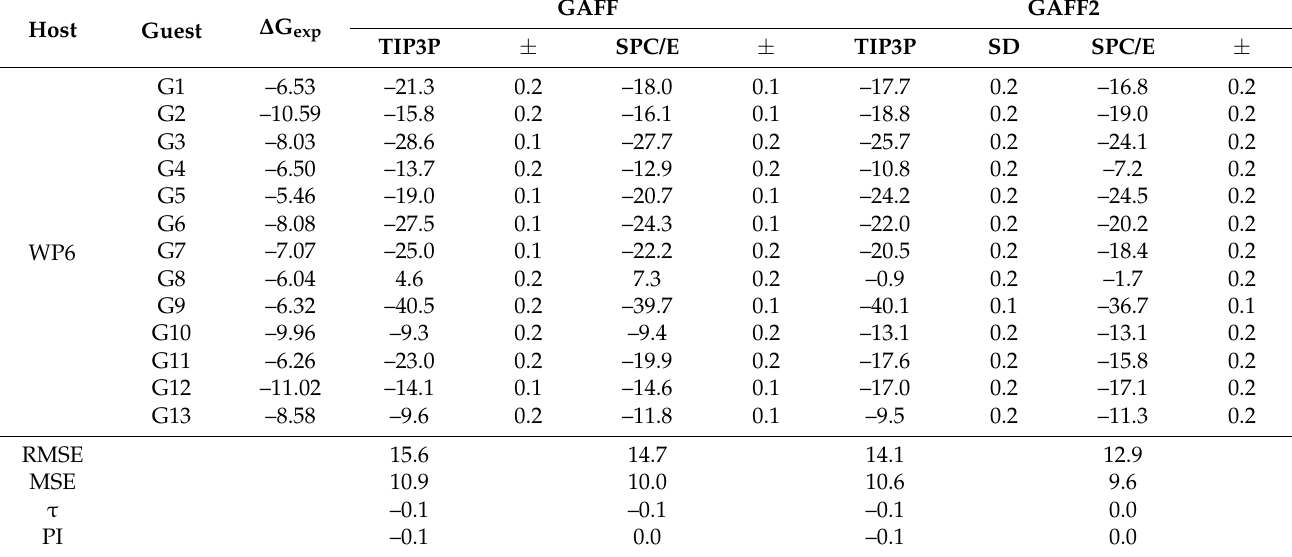
Table 2. Single-trajectory MM/GBSA estimates under GAFF and GAFF2. MSE, RMSE, τ , and PI serve as quality